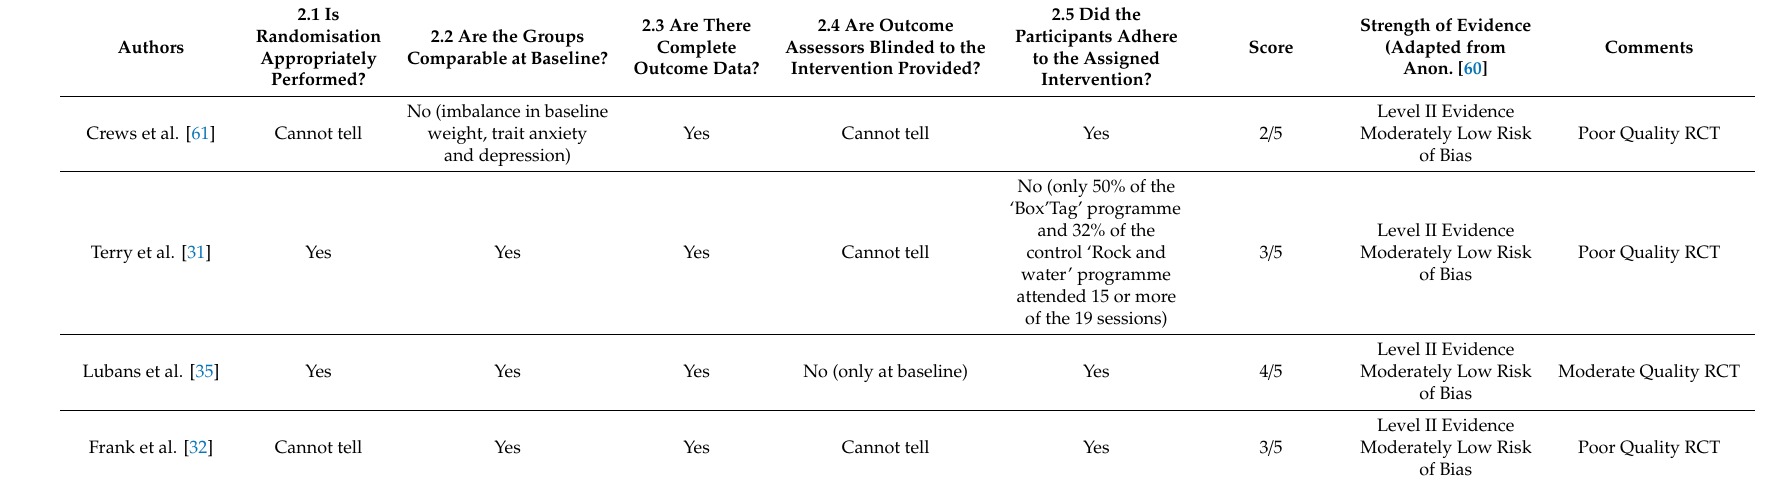
Table 3. Quality Assessment for quantitative randomised control trials using MMAT